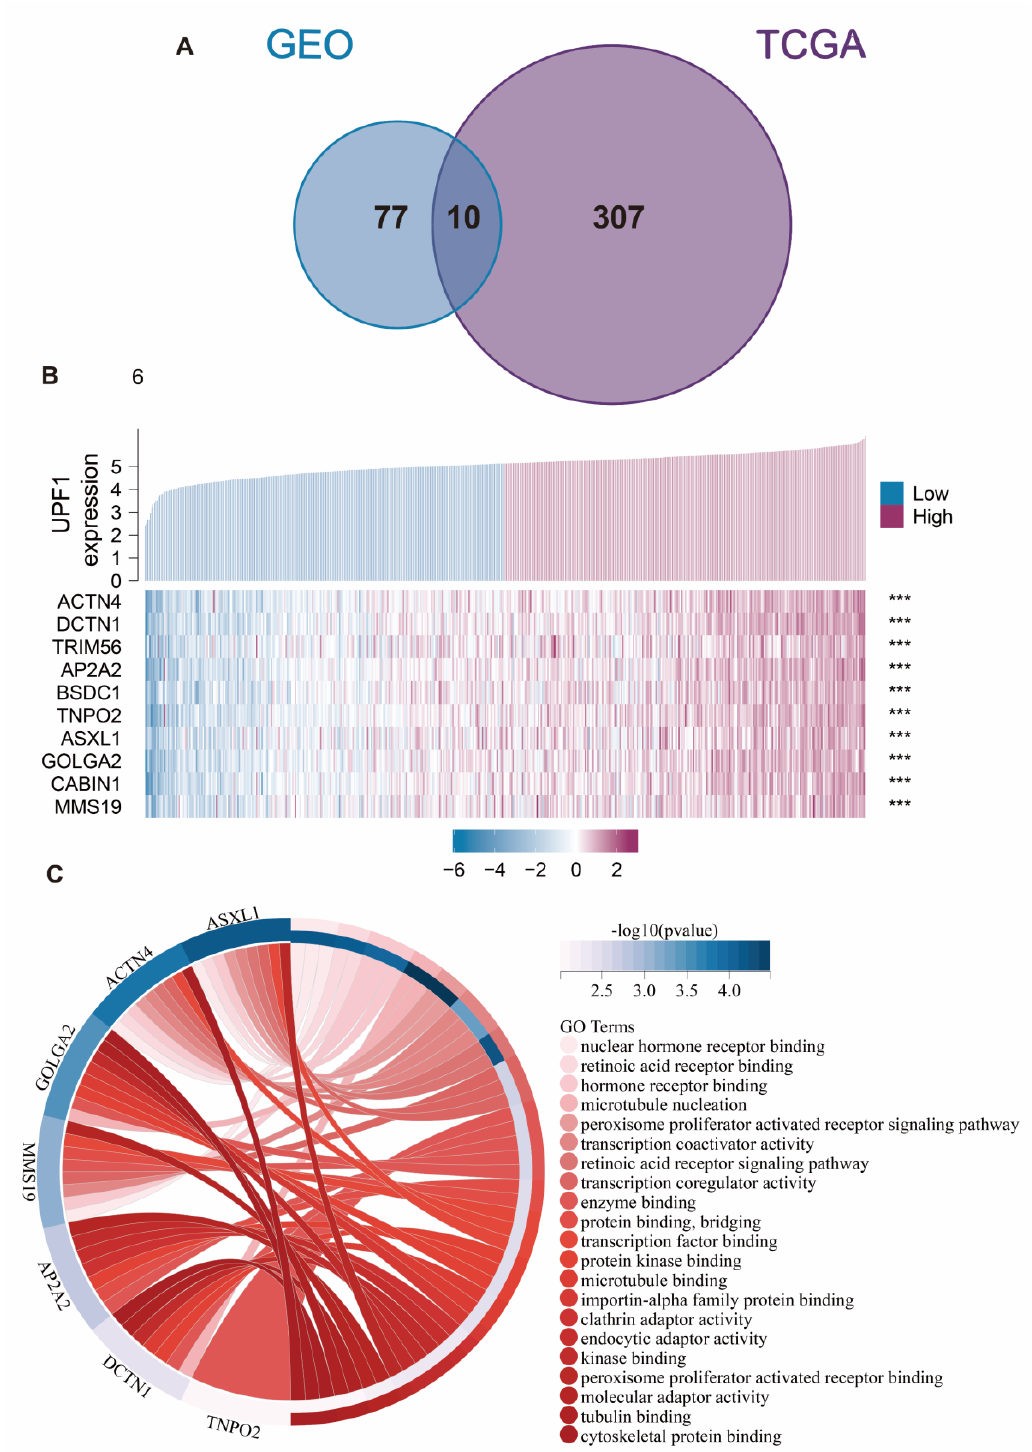
Figure 6. ( A ) Venn diagram shows the intersection of module genes in key modules. ( B ) Heatmap of key co-expression genes expression levels and UPF1 expression levels, and the correlation between them were exhibited, *** p < 0.001. ( C ) Chord diagram shows the GO terms that these key co- expression genes were enriched in.